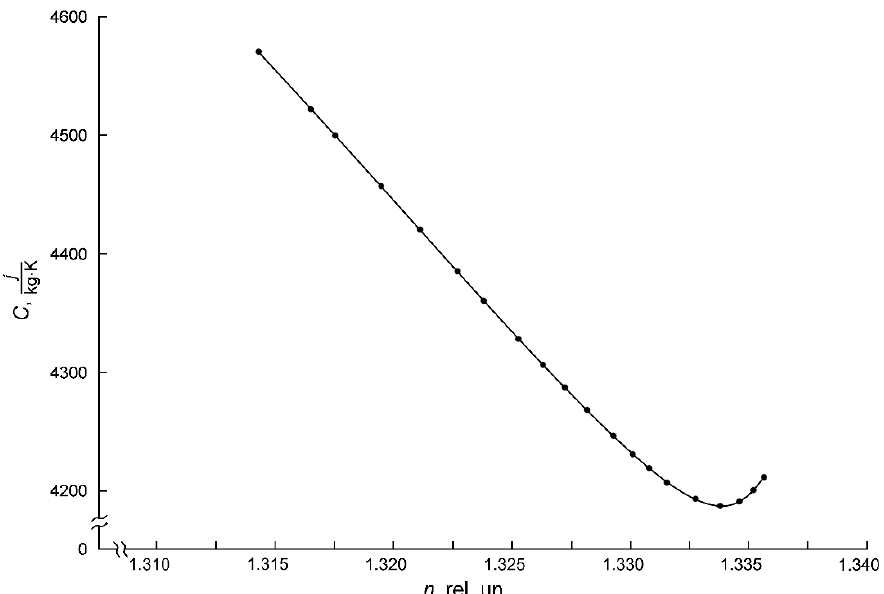
Figure 5. The ratio between the value of the specific heat capacity C of the feed water and the value of its refractive index n .